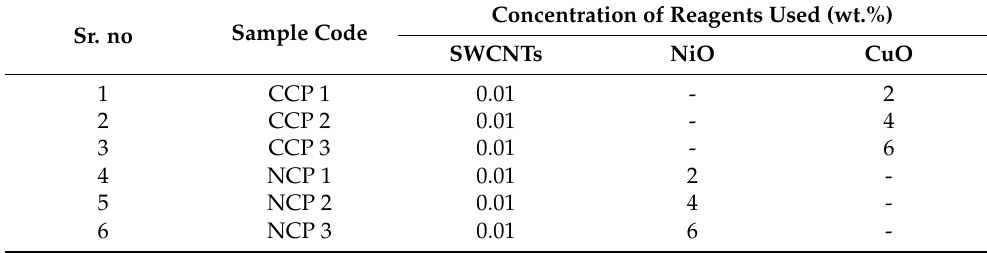
Table 1. The concentrations of MOs in polymer/SWNT/MO composites.